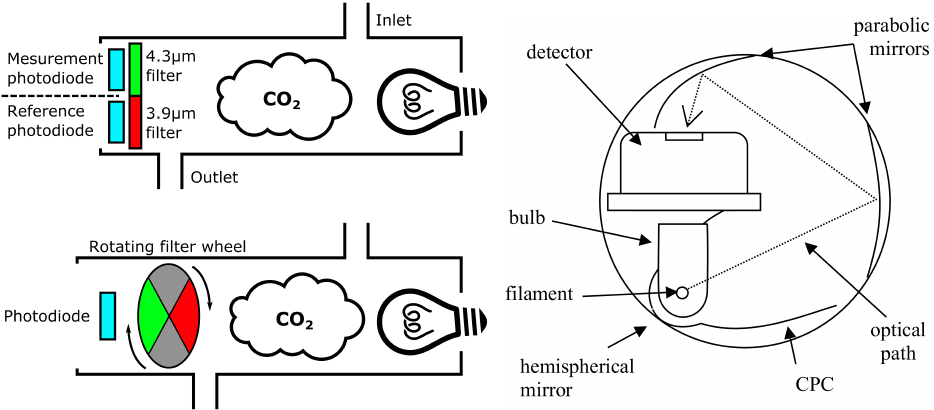
Figure 2. ( Left ) outline schematic of a space-interleaved ( top ) and time-interleaved ( bottom ) NDIR CO 2 sensor. In the time-interleaved sensor, a rotating filter wheel acts as a chopper, with two opaque sectors, and two sectors equipped with 4.3 µm and 3.9 µm bandpass filters, respectively. ( Right ) a more complex design allowing for longer light paths in a compact device. The detector has two channels, a measurement and a reference one, as in the upper left scheme. CPC stands for Compound Parabolic Collector, a type of light concentrator. Reproduced with permission from Hodgkinson et al.